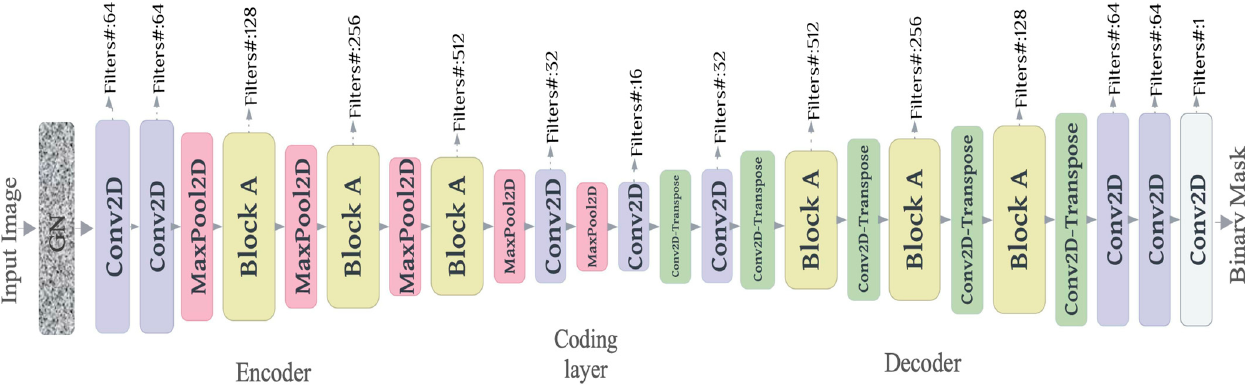
Figure 4. The autoencoder’s architecture is used to annotate the sinkhole dataset. The input image is passed through a GN layer, progressively filtered, and down-sampled at each layer in the encoder part. The decoder path on the right performs up-sampling operations to reconstruct a binary-masked image. Block A is the separable depth block shown in Figure 2. The coding layer size is 8 × 8, with 16 filters.